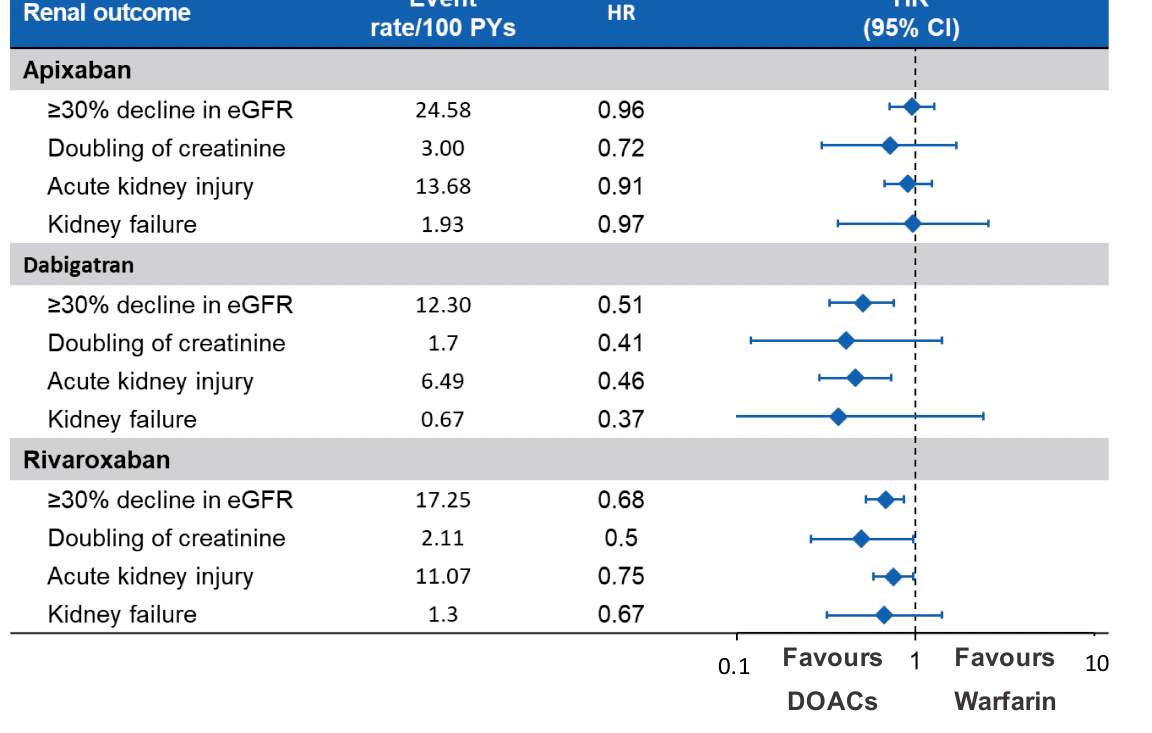
Figure 7. Comparison between DOACs and Warfarin in terms of renal preservation in diabetic patients.